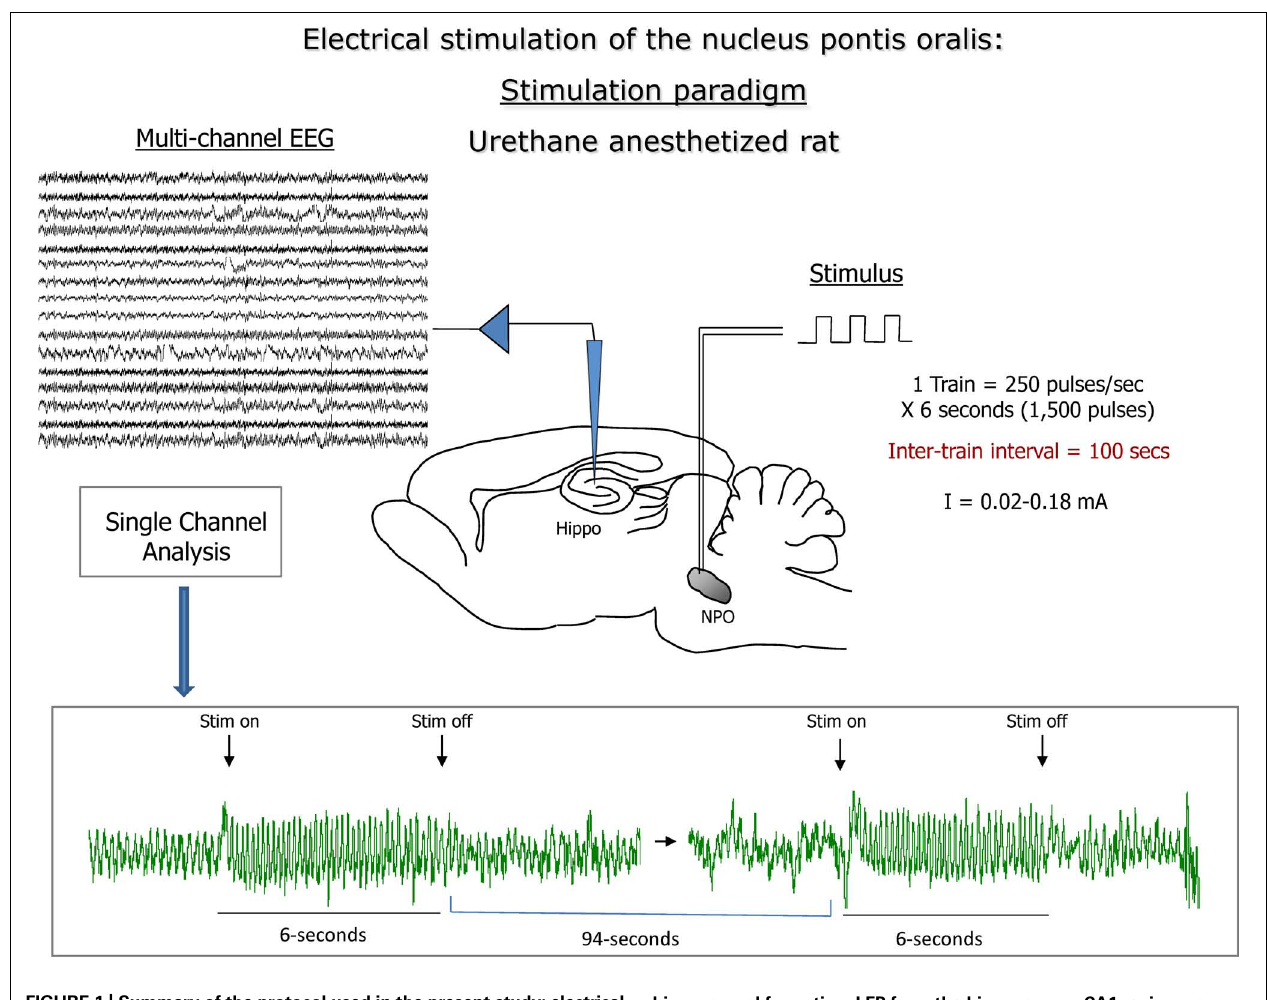
hippocampal formation; LFP from the hippocampus CA1 region was analyzed in the present study. Following fast Fourier transformation (FFT) of the LFP frequency of the highest power component (Peak frequency), and total power in the theta frequency band (3–12 Hz) were recorded for each stimulation